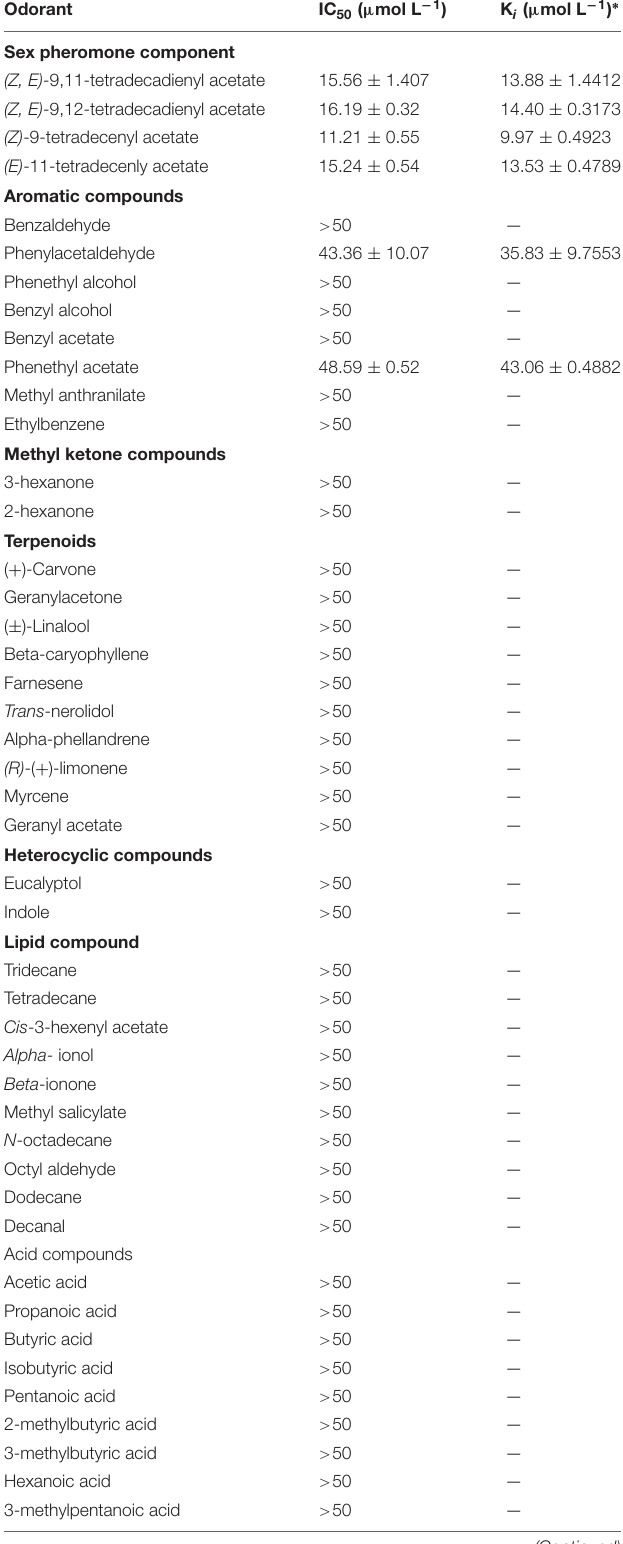
TABLE 1 | Primers used for identification, expression analysis and expression vector construction of SlitOBP11 . Purpose